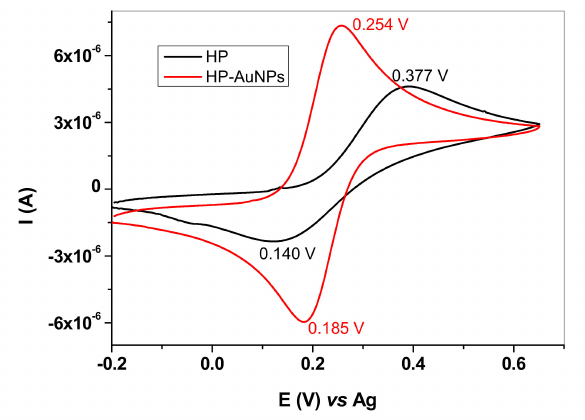
Figure 3. Cyclic voltammograms recorded with HP (black) and HP-AuNPs flexible electrode (red). Electrolyte: 1 mM K 4 [Fe(CN) 6 ] + 0.2 M KCl; scan rate 10 mVs − 1 .